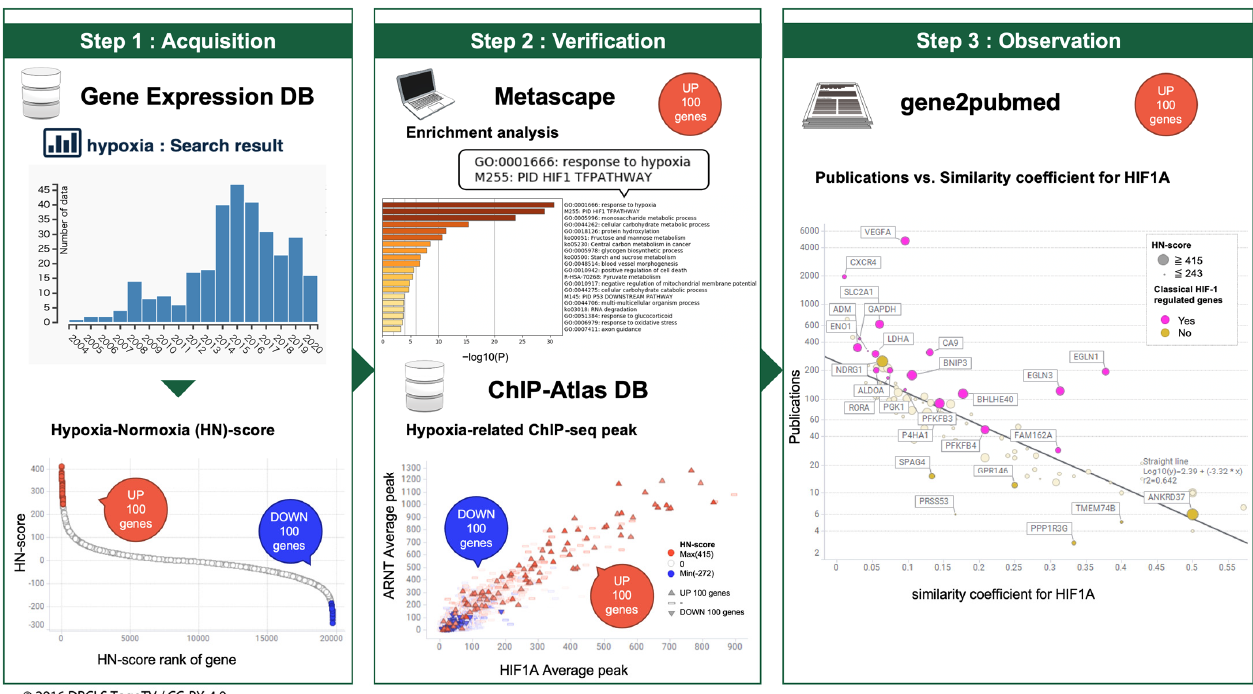
Figure 1. Schematic view of hypoxic transcriptome meta-analysis. Step 1. Evaluation and listing of upregulation and downregulation of hypoxia-inducible genes. Step 2. Confirmation of known hypoxic stimulation-related genes. Step 3. Discovery of novel genes related to hypoxic stimulus-response.